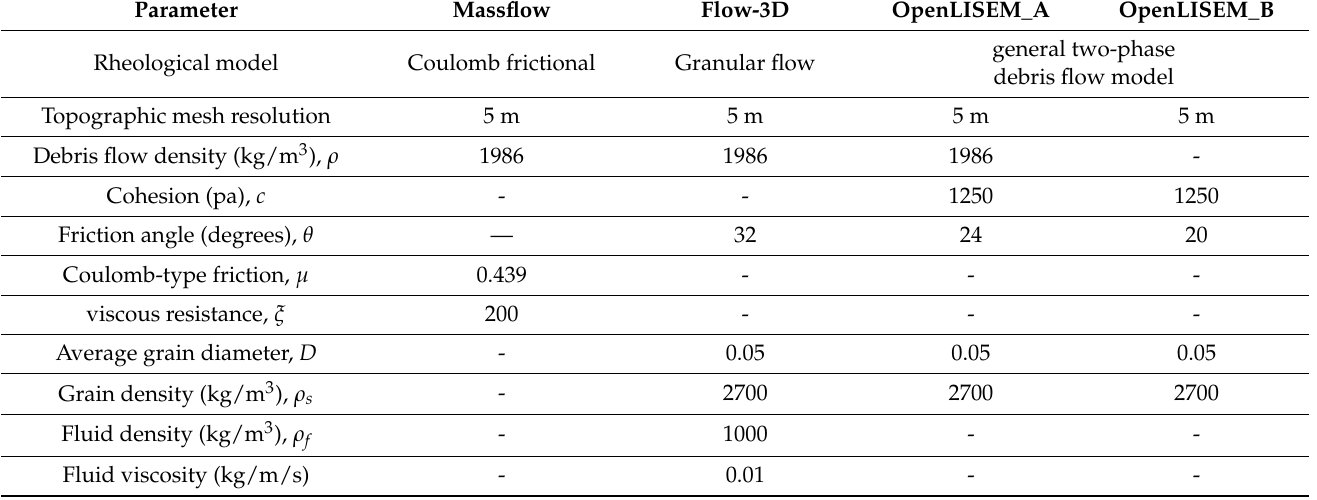
Table 2. Best-fit model parameters used in Massflow, Flow-3D, OpenLISEM_A, and OpenLISEM_B simulations of the Wayao debris flow in 2013. A range of some debris parameters was measured by field measurement and laboratory